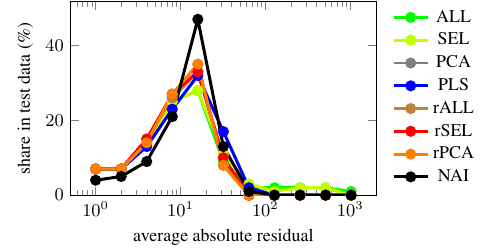
Figure 5. Analysis of residuals. Figure5. Analysisofresiduals. Fig. 5. Analysis of residuals. Fig. 5. Analysis of residuals.